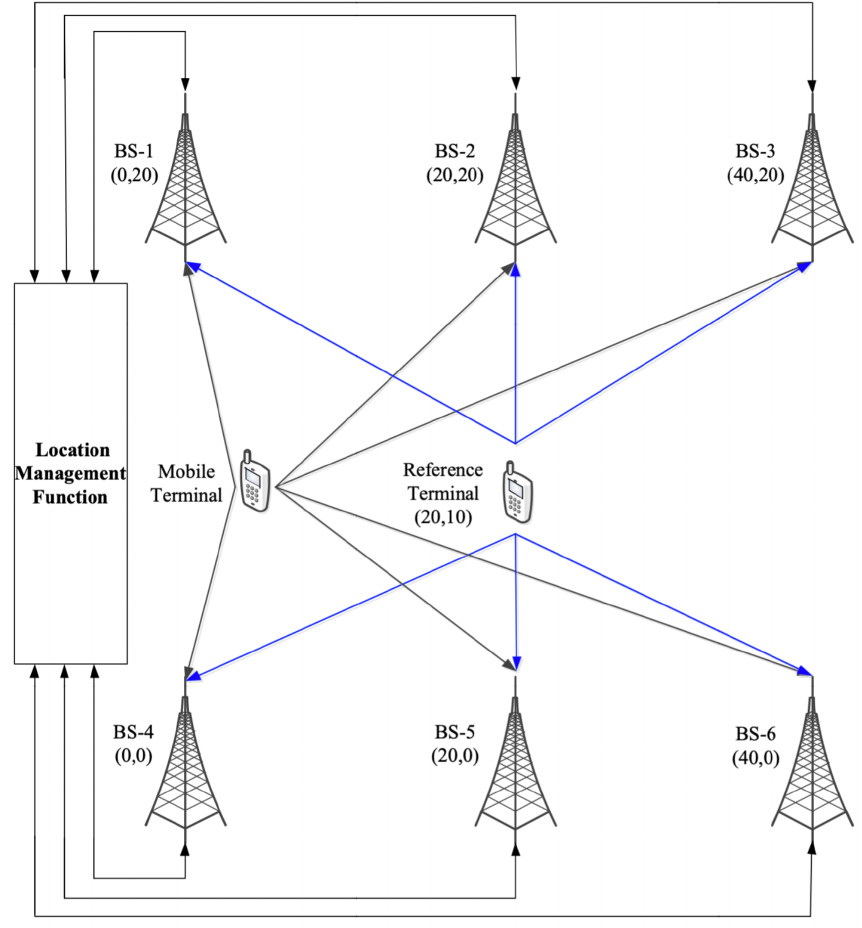
Figure 3. Terminal positioning